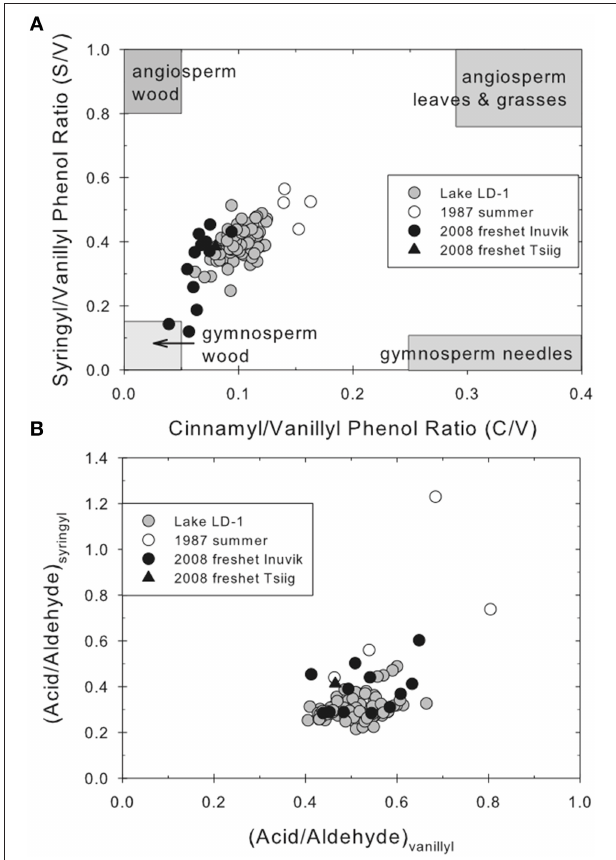
FIGURE 7 | Plots of lignin parameters, including (A) S/V vs. C/V ratios for all samples, with boxes drawn from the literature depicting accepted ranges for common sources of OC, and (B) acid-to-aldehyde ratios for syringyl vs. vanillyl phenols for all